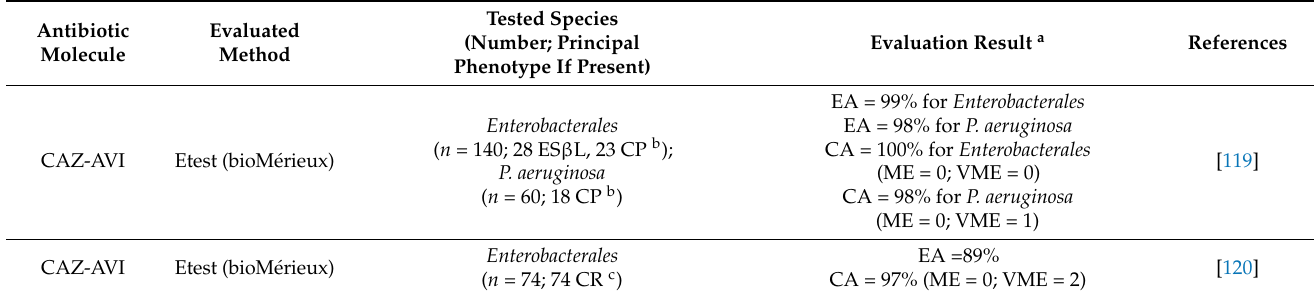
Table 2. Evaluation of different commercial methods vs. reference technique for AST of cef- tazidime/avibactam (CAZ-AVI), meropenem/vaborbactam (MER-VAB) and imipenem/relebactam